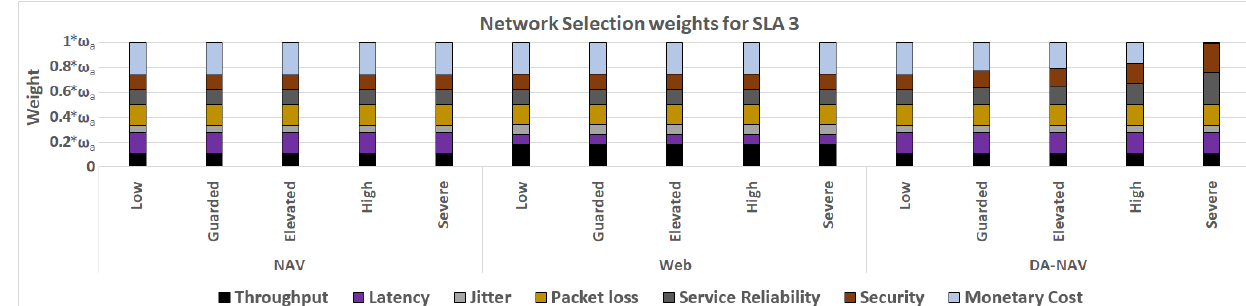
Figure 17. Network selection weights for SLA2.